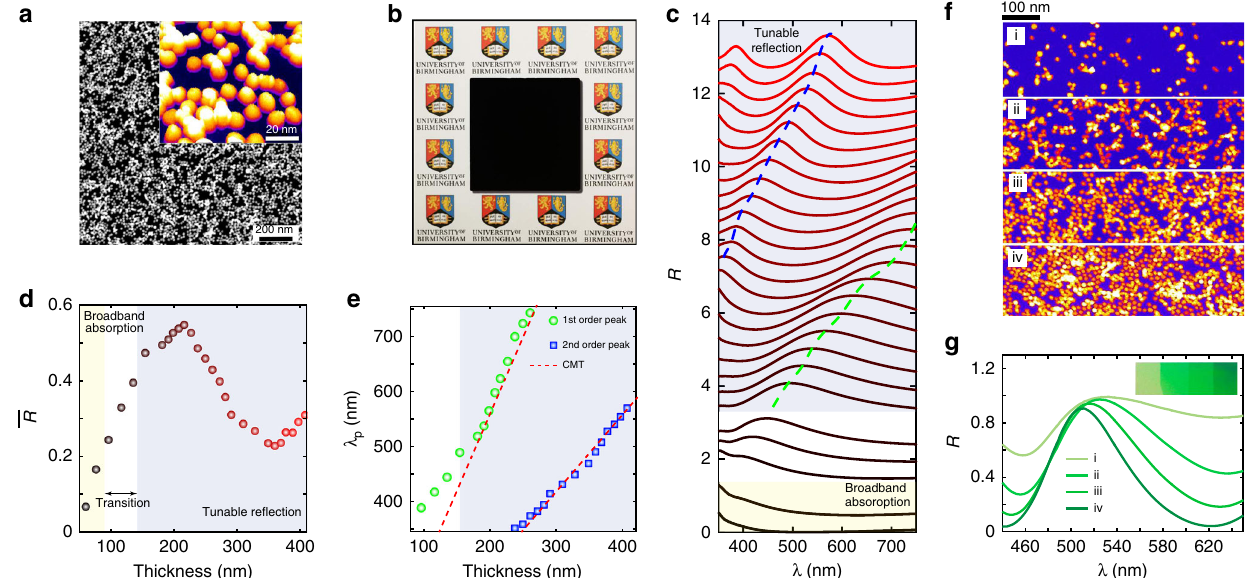
Fig. 3 Experimental realisation of the disordered plasmonic system. a A typical STEM picture of Ag nanoclusters. The inset shows the 3D reconstruction plot. Disorder is introduced to the system by the deformed shapes and randomised positions of the clusters. b A sample with a fi xed thickness around 60 nm, producing a completely black colour due to the disorder-induced broadband absorption. c The re fl ection spectra of the structure at different thicknesses, with re fl ection peaks marked as dashed lines. The transition is experimentally observed from broadband absorption to band-limited re fl ection with thickness-dependent re fl ection peaks. d The averaged re fl ection R from 350 to 750 nm as the thickness varies. e The relationship between the peak shift and thickness from experiment, which shows a good match with our model based on coupled mode theory (red dashed lines). f STEM pictures for the hybrid platform with four different nanoparticle densities. g The corresponding re fl ection spectra for samples with different densities. The inset shows a photographic image, illustrating the vivid colour generation from the sample with stronger Fig. 2c, but with different spacer thickness. The situation of broadband absorption is shown in Fig. 2g while a spectrally con fi ned re fl ection band is depicted in Fig. 2h. In Fig. 2g, most photons are trapped inside the plasmonic system and dissipated, with miniscule re fl ection (above the black dashed line), while a signi fi cant portion of the photons are re fl ected for the case with mismatch between 1 ∕ τ e and 1 ∕ τ k 0 (Fig. 2h).